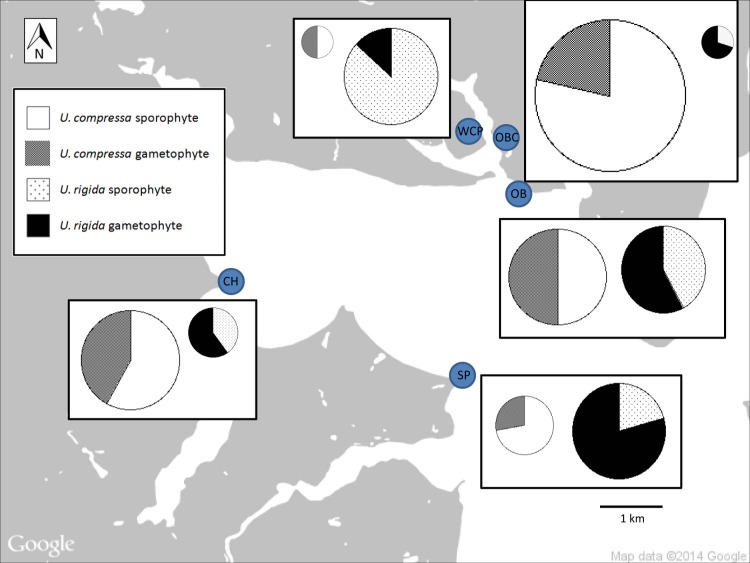
Map of Greenwich Bay (a subset of Narragansett Bay, Rhode Island).This figure shows the relative proportion of gametophytes and sporophytes present at five sites in Greenwich Bay during the 2013 bloom-forming season. The sites are Warwick City Park (WCP), Oakland Beach Cove (OBC), Oakland Beach (OB), Sandy Point (SP), and Chepiwanoxet (CH). Pie chart sizes represent the relative number of individuals sampled.